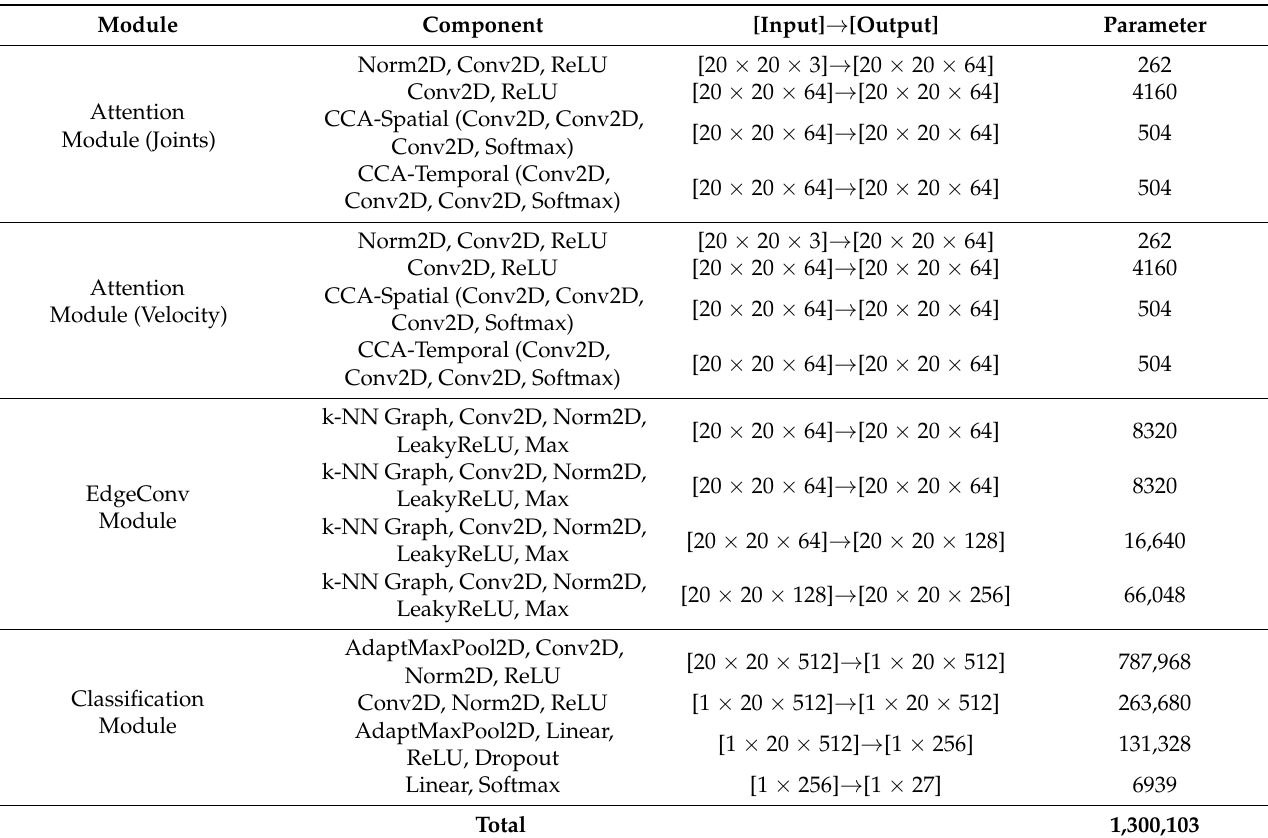
Table 7. Details of each module in proposed model for